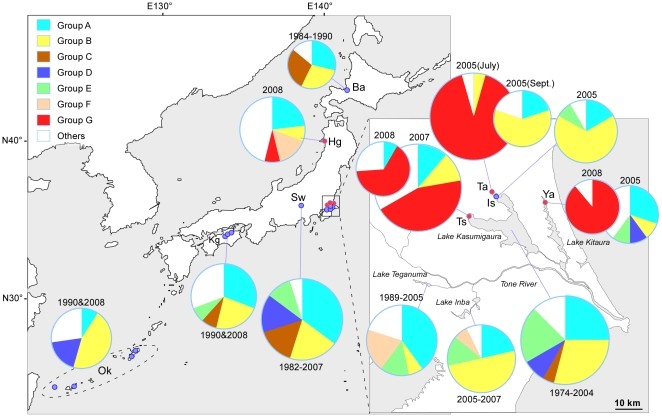
Distribution of Microcystis aeruginosa STs in Japan.ST proportions at each sampling location are displayed as pie charts, the size of each being proportional to the number of STs. Intraspecies groups are indicated by different colors as defined in the phylogenetic tree in Fig. 1. Note that the same ST is included in the number of STs in the pie chart indicating pooled samples when they were isolated from different points of time or place. Furthermore, the same ST is not included when it was isolated from the same bloom to avoid the effect of biased sample collections. Red circles on the map indicate locations from where group G strains were isolated whereas blue circles indicate locations from where group G strains were not obtained. Abbreviations for sampling locations are as follows: Ba, Lake Barato; Hg, Hachiro Lagoon; Sw, Lake Suwa; Kg, reservoirs in Kagawa Prefecture; Ok, dams in Okinawa Prefecture; Ta, Takasaki; Is, Iseki; Ts, Tsuchiura; and Ya, Yasuzuka.